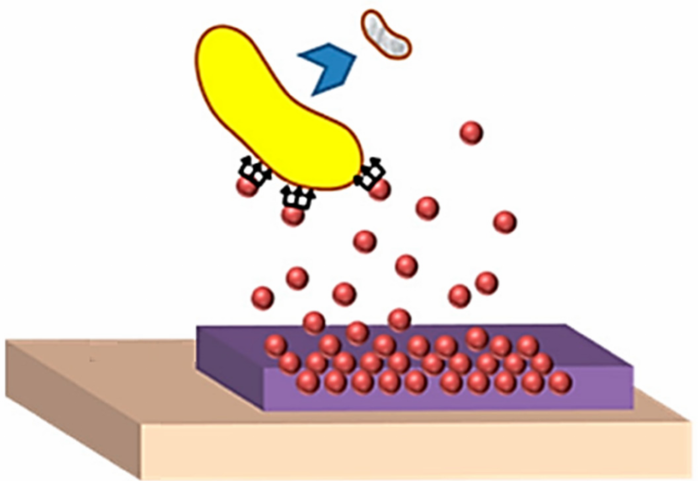
Figure 2. Mechanism of preventing bacterial attachment by using surface coatings